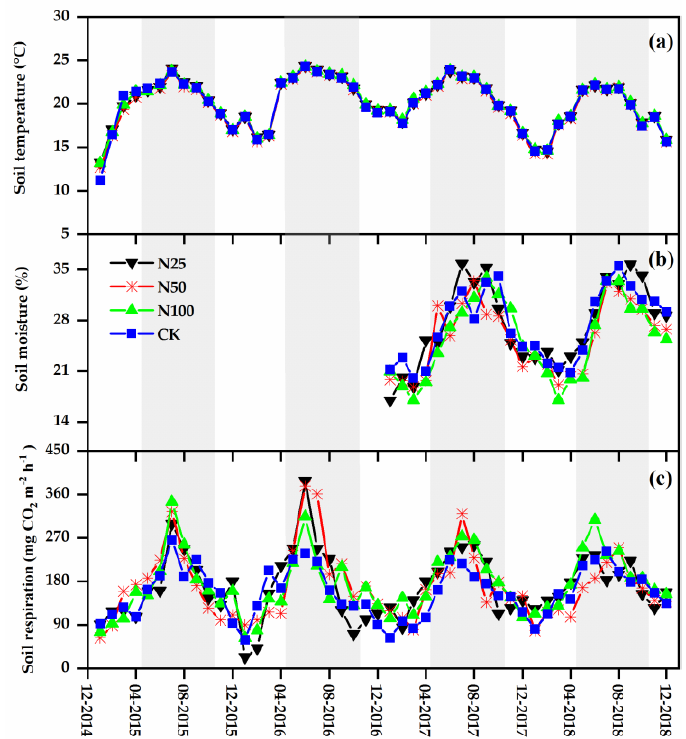
Figure 1. Changes in soil temperature ( a ), soil moisture ( b ), and soil respiration ( R S ) ( c ) measured in a tropical montane rainforest within the JFLNNR from January 2015 to December 2018. The shaded areas indicate the wet seasons (May – October). N25, N50, N100, and CK represent 25, 50, 100, and 0 kg N ha −1 a −1 nitrogen (N) addition treatments, respectively. From January 2015 to December 2016, the soil moisture was not observed. Table 1. Selected soil characteristics under different N treatments. N additions had no significant impacts on any variable shown.